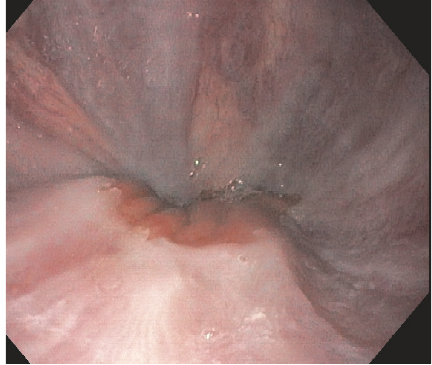
Figure 2: Endoscopic view of a trace varix.